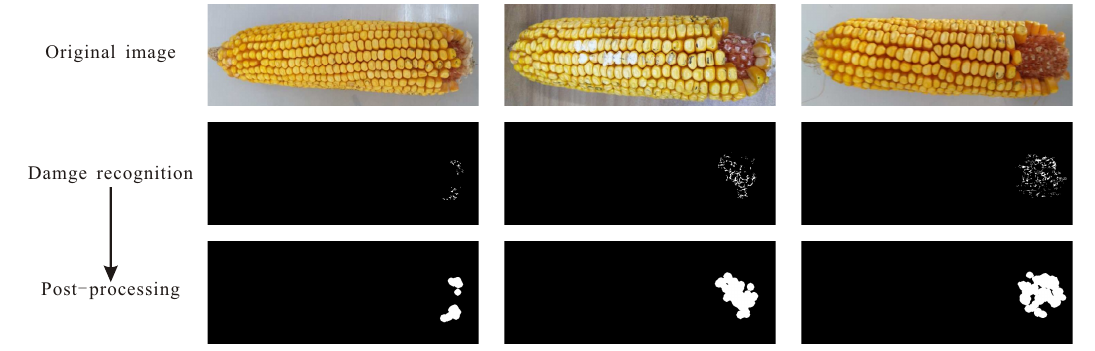
Figure 10. Results on damage region recognition of a single ear.